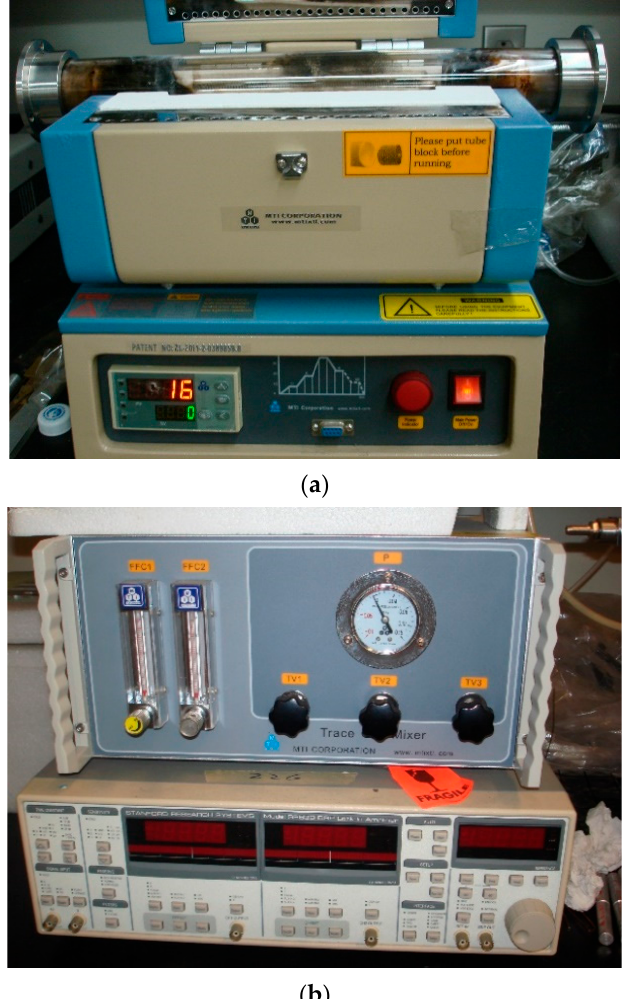
Figure 2. Photos showing the set-up for the fiber heat treatment: ( a ) split furnace with a quartz tube as the reaction chamber; ( b ) multi-channel gas-flow-controlling unit. as the reaction chamber; ( b ) multi-channel gas-flow-controlling